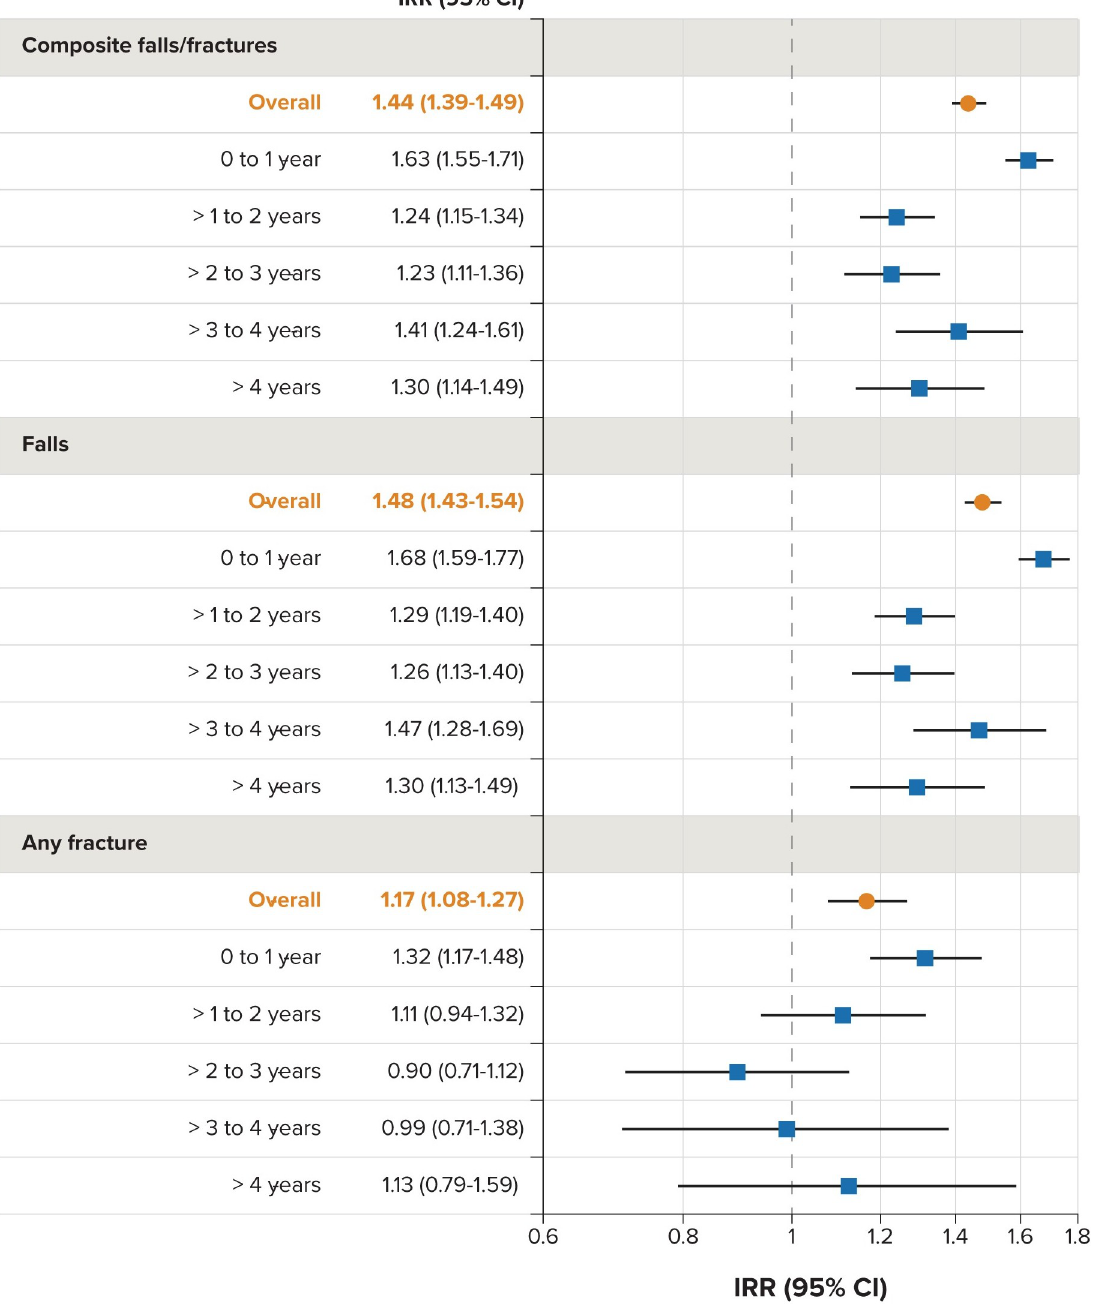
psychosis being retained and included in the analysis. While a large proportion of patients with PD without psychosis were excluded by the matching, the characteristics of the resulting matched cohort were very well-balanced between the PD without psychosis and PDP groups (e.g., mean age of 78 years, greater than 60% proportion of male patients, and a high